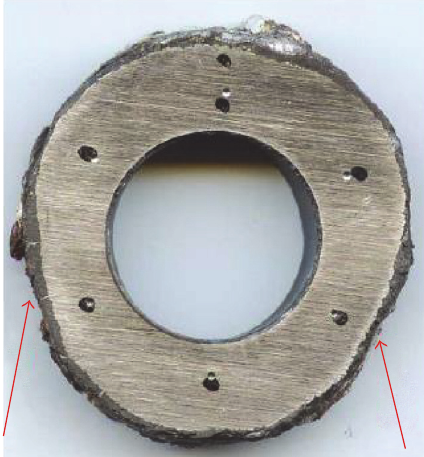
Figure 11: Cross section image of a boiler tube [10]; anodic zones with high metal loss rate are indicated.